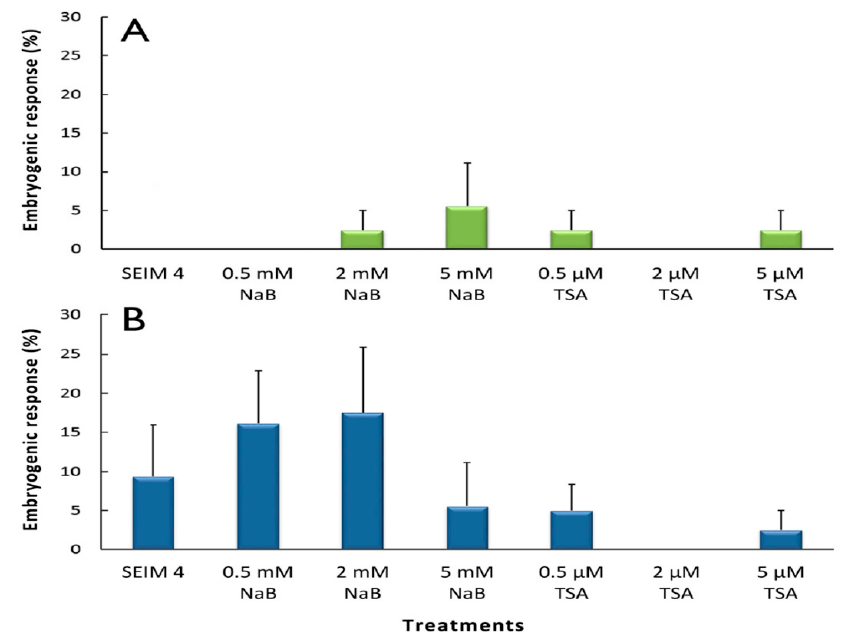
Figure 4. Effect of HDAC inhibitors (NaB and TSA) on the embryogenic response in grapevine cv. Mencía recently germinated somatic embryos. The percentage of explants with an embryogenic response (mean ± standard error) after ( A ) 4 and ( B ) 8 weeks of culture is shown. There were no statistically significant differences between any of the treatments ( p < 0.05).